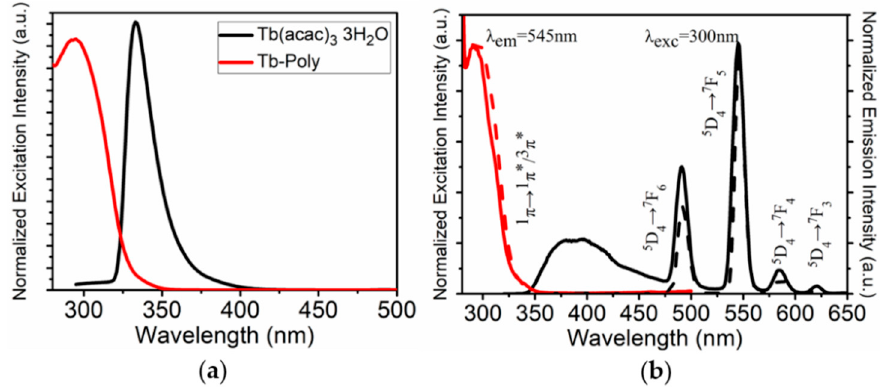
Figure 3. ( a ) Excitation spectra of Tb(acac) 3 3H 2 O (black) and Tb-Poly (red) in DMF solution. ( b ) Excitation and emission spectra of Tb-Poly in DMF (dash line) and in NPs (solid line), respectively.